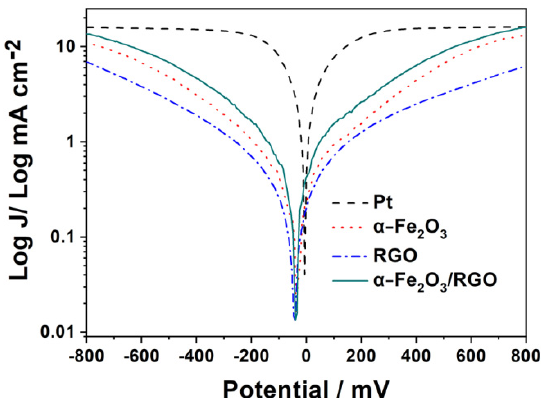
Figure 6. Tafel curves of the symmetrical cells fabricated with two identical α -Fe 2 O 3 /RGO, α -Fe 2 O 3 , RGO, and Pt electrodes.